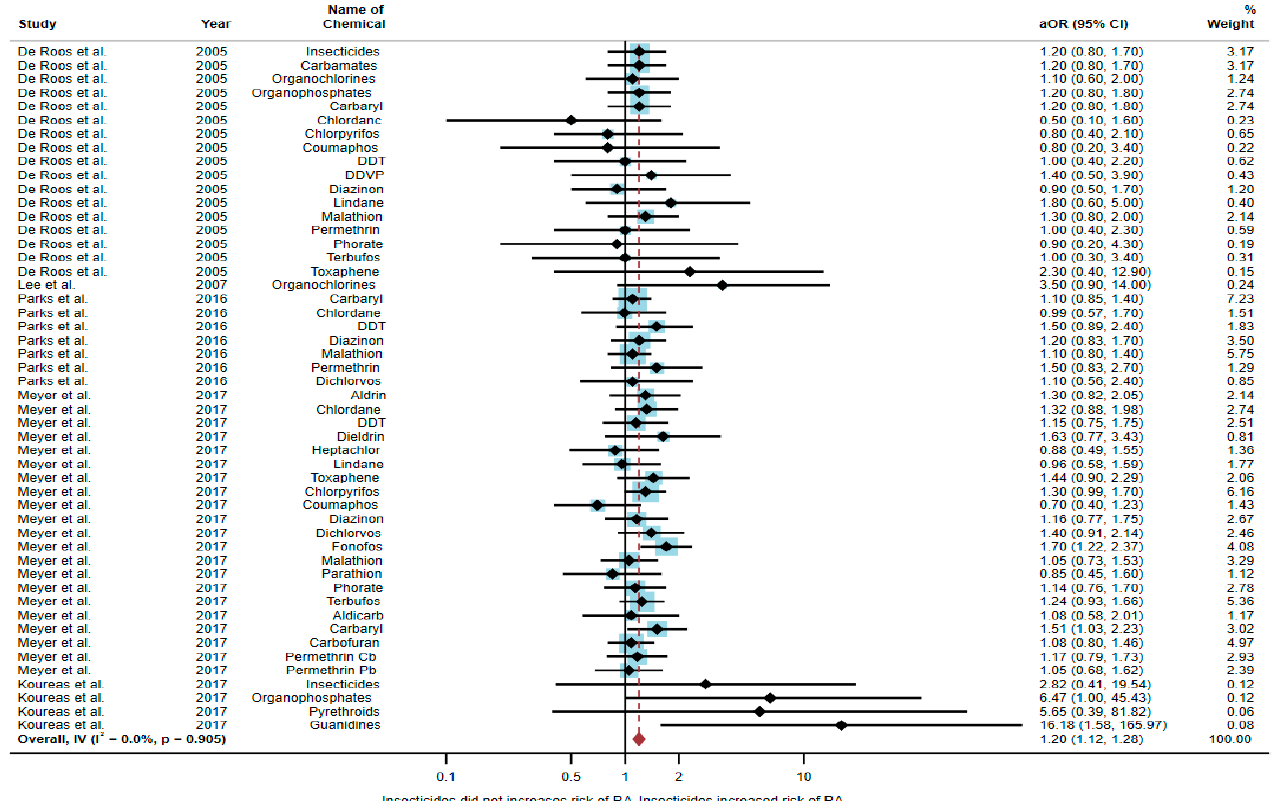
Figure 2. The association between exposure to insecticides and RA development [6,17,18,20,21]. aOR, adjusted odds ratio; 95% CI, 95% confidence interval.